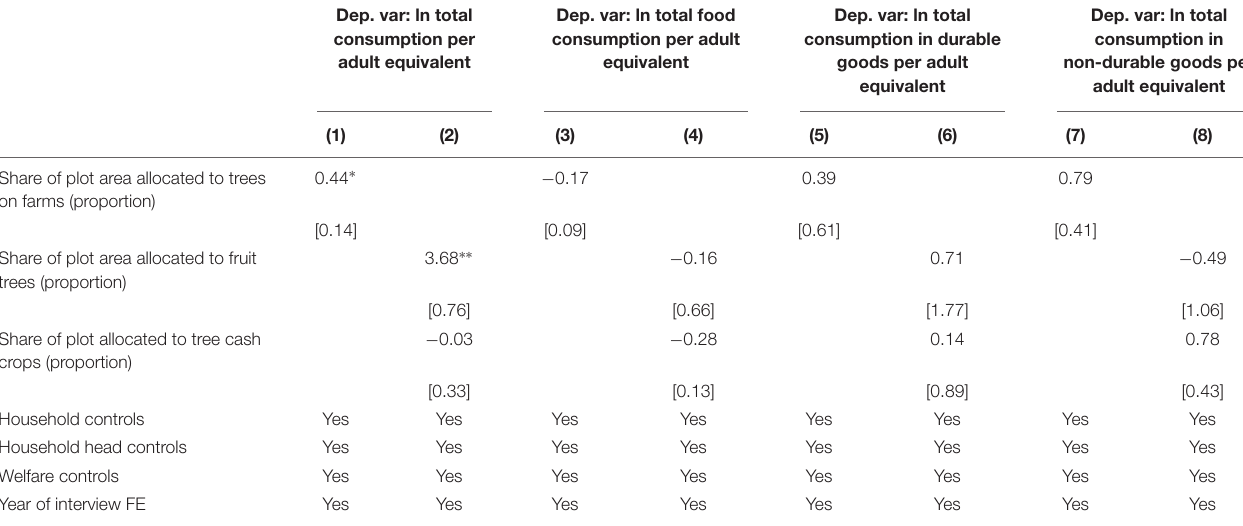
TABLE 4 | Fixed-effects model results on household consumption and trees on farms adoption (excluding bananas as a fruit tree). Dep. var: ln total consumption per